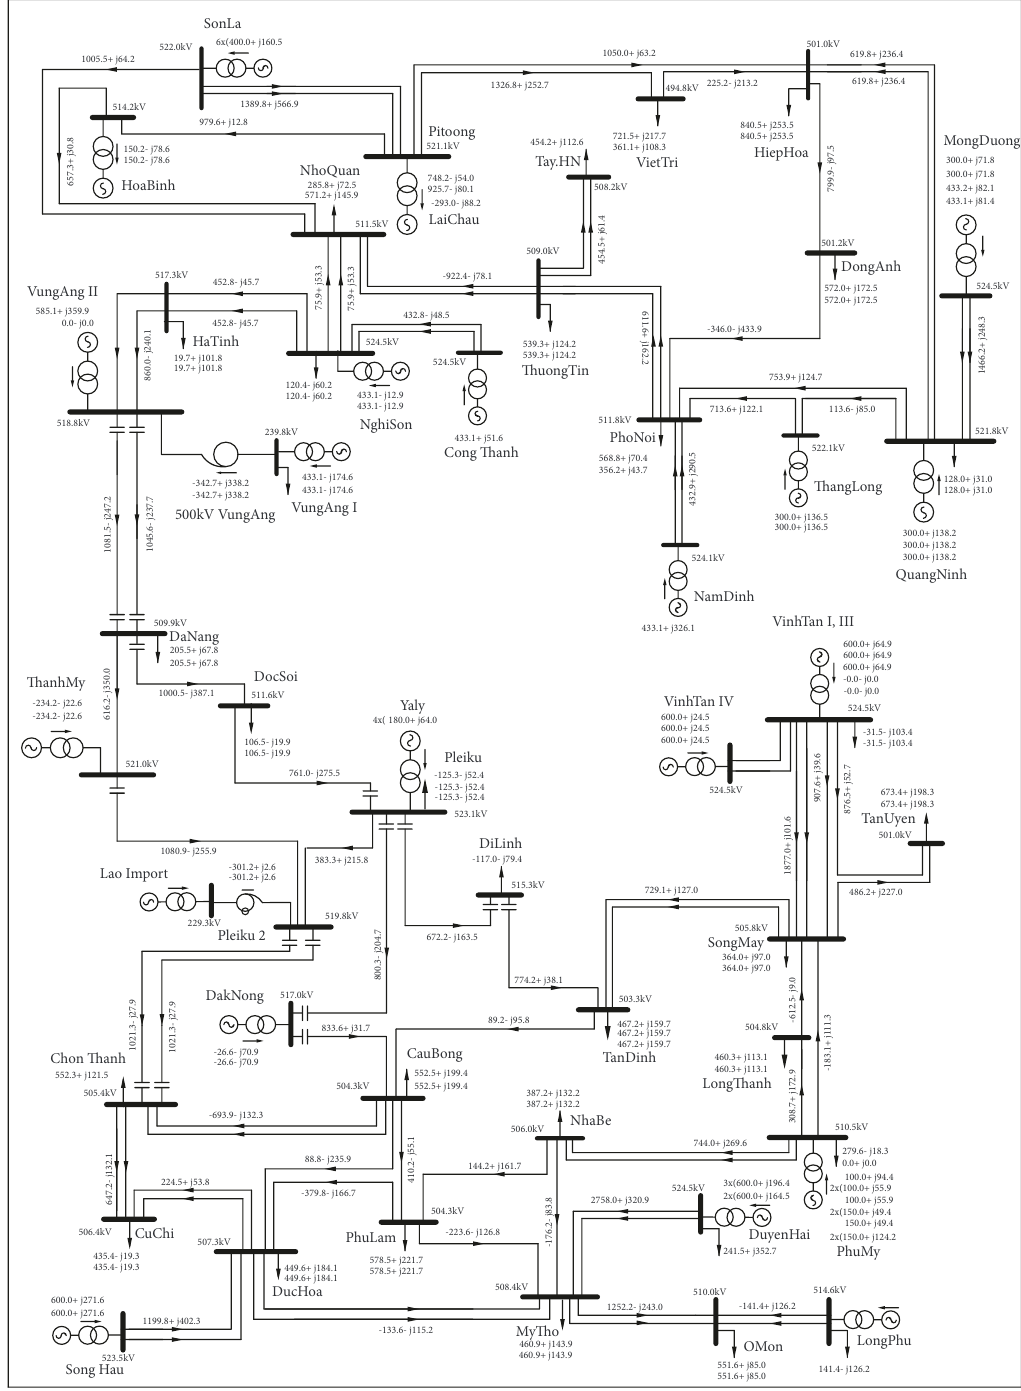
Figure 3: The result of load flow calculation on the Vietnamese 500kV power system 2020 for the maximum load requirement.